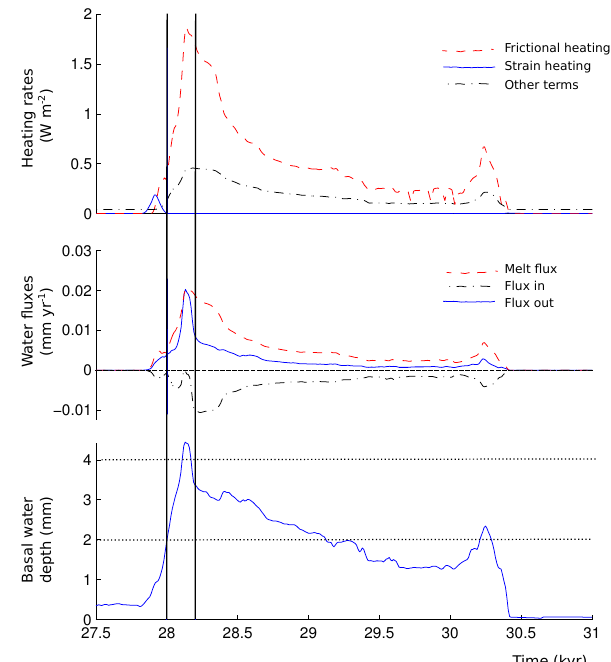
Figure 5. Time series of various quantities averaged across Hudson Strait at the location marked by the blue dot in Fig 2a. The top panel shows heating rates in the lowest model level (Wm − 2 ). Red dashed line: frictional heating; blue solid line: strain heating; black dashed line: other heating terms (which include the geothermal heat flux). The middle panel shows water fluxes (mmyr − 1 ). Red dashed line: melting; blue solid line: flux of water out of the box (the flux from which the water depth is calculated); black dashed line: the differ- ence between the flux out of the box and the melt rate. A positive value means that there is a flux of water from upstream into the box; a negative value means that the flux of water out of the box is greater than the melt rate and the box loses water downstream. The bottom panel shows the water depth at the base of the ice sheet